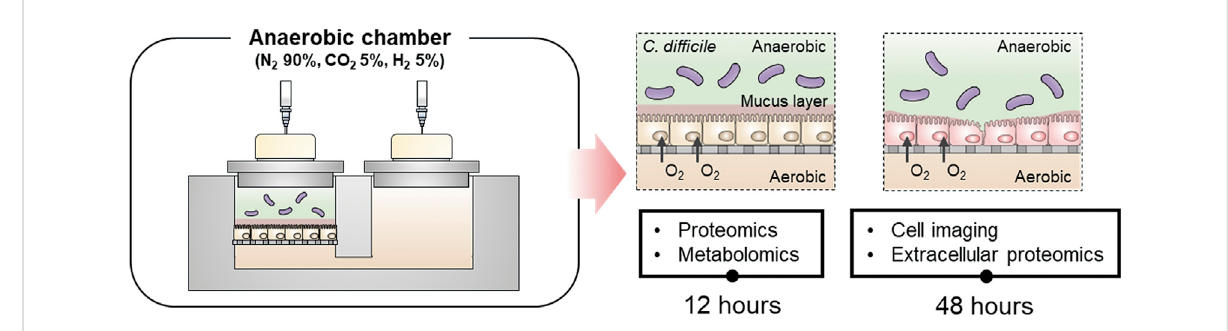
FIGURE 1 Overall scheme of the coculture process between human gut epithelial cells and C. dif fi cile to analyze an integrative multiomics approach at 12 h and con fi rm toxin-mediated CDI at 48